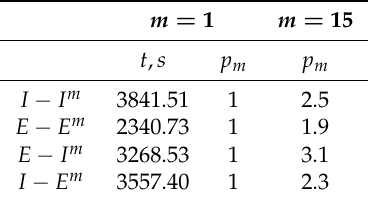
Table 7. An efficiency p m obtained with the mixed time partitioning